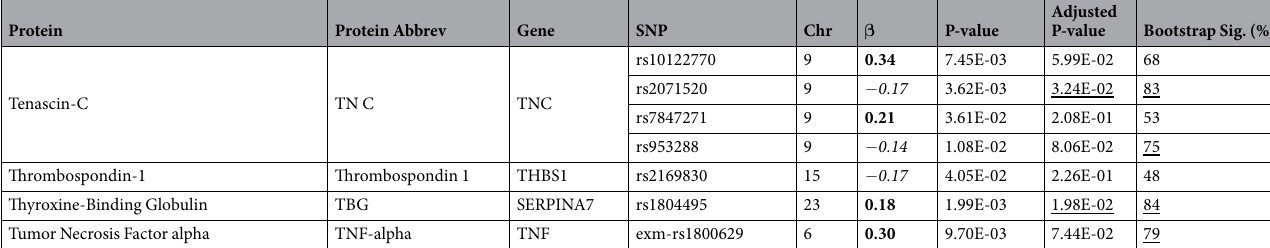
Table 2. Association of 115 SNPs with expression of 45 proteins. Chr, chromosome; β , regression coefficient estimates; Italic, negative association; Bold, positive association; Underline, Adjusted P-values < 0.05 or SNP- protein association significant (P-value < 0.05) in at least 70% of 1000 bootstrap